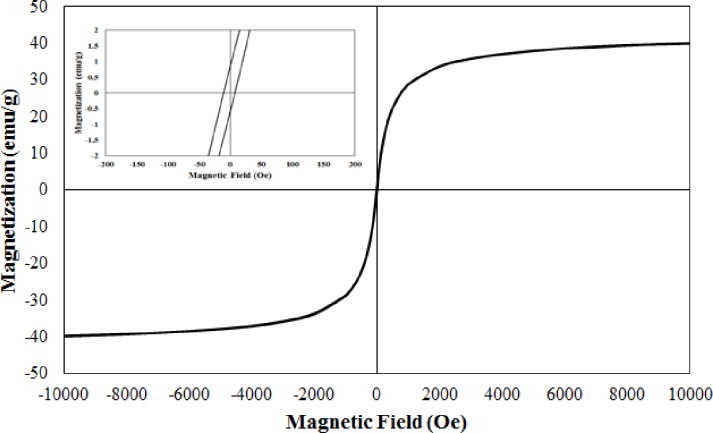
Room temperature magnetization curve and a close view of the magnetization curve (inset) of M-rGO3.